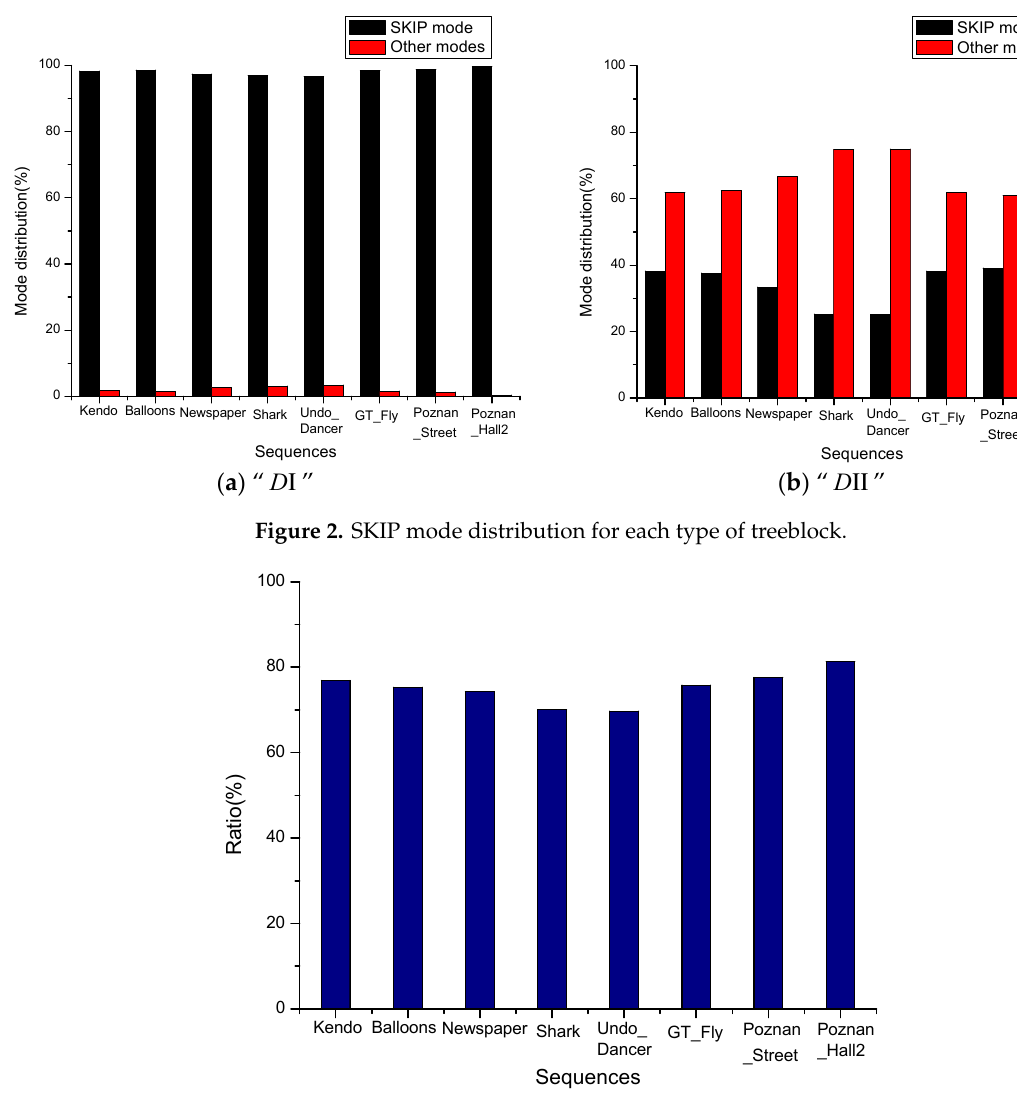
Figure 3. Statistical analysis of the ratio of “ Ι D ” treeblocks.